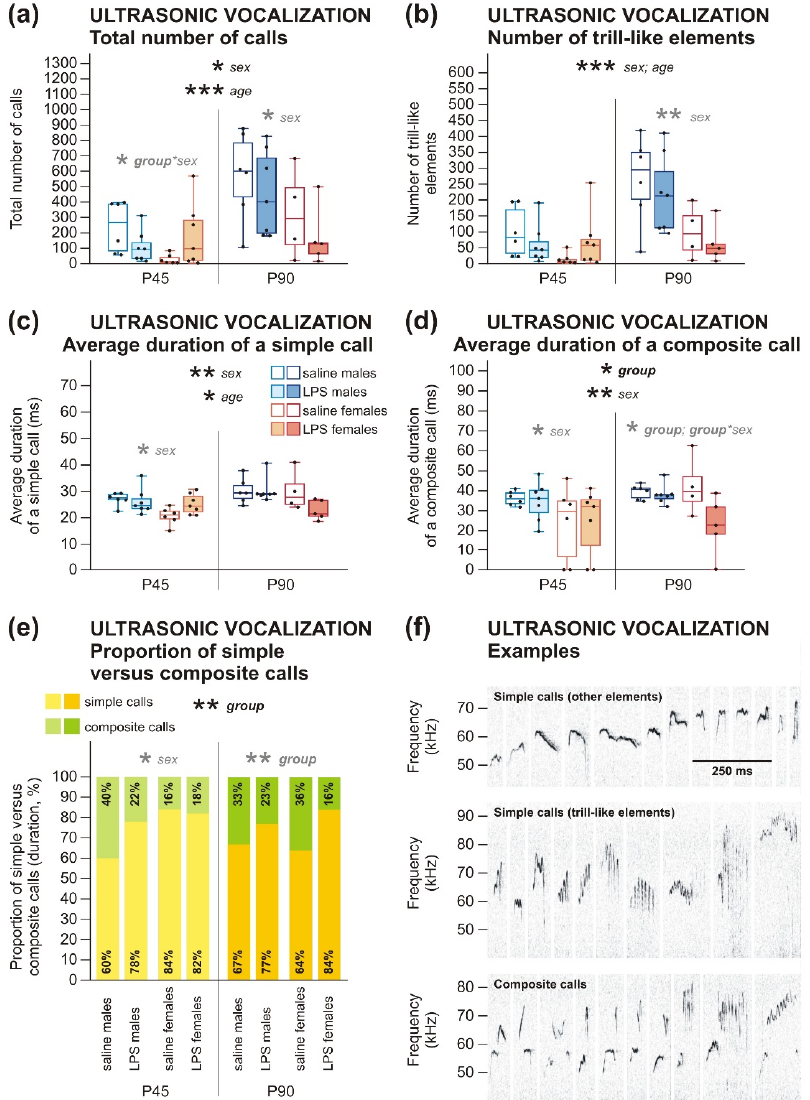
Figure 4. Ultrasonic vocalization (USV) in P45 and P90 rats. ( a ) In adolescence, a distinct effect of LPS on males and females was found in total number of calls. 2wANOVA revealed that LPS males emitted less vocalizations compared to control males, but LPS females emitted a higher amount of vocalization compared to control females. In adulthood, the difference was not present. In addition, males emitted a higher total number of calls than females. Adult animals produced much more vocalizations than adolescents. ( b ) Trill-like USV was not affected by LPS in any age. However, males emitted a higher number of trill-like elements than females, and also adult rats had a higher number of trill-like elements in comparison to adolescents. ( c , d ) Average duration of a simple call did not differ between groups. However, adult females prenatally exposed to LPS showed a shorter average duration of a composite call than control females, as 2wANOVA revealed. 3wANOVA-RM also revealed longer average duration of simple calls and composite calls in males in comparison to females. Average duration of simple calls was significantly higher in adult animals than adolescents; in the composite calls, the same tendency was present as a strong trend. ( e ) The proportion of simple versus composite calls was changed in LPS-exposed rats, as shown by 3wANOVA-RM and 2wANOVA. LPS-exposed rats of both sexes, especially at P90, spent shorter time by emission of composite calls than simple calls, compared to controls. In addition, P45 males spent a longer time emitting the composite calls, relative to the simple calls than P45 females. ( f ) Examples of analyzed types of USV: simple calls, trill-like elements, composite calls. The boxplots show median, first and third quartile, and minimum and maximum values; the dots show individual values. * p < 0.05, ** p < 0.01, *** p <